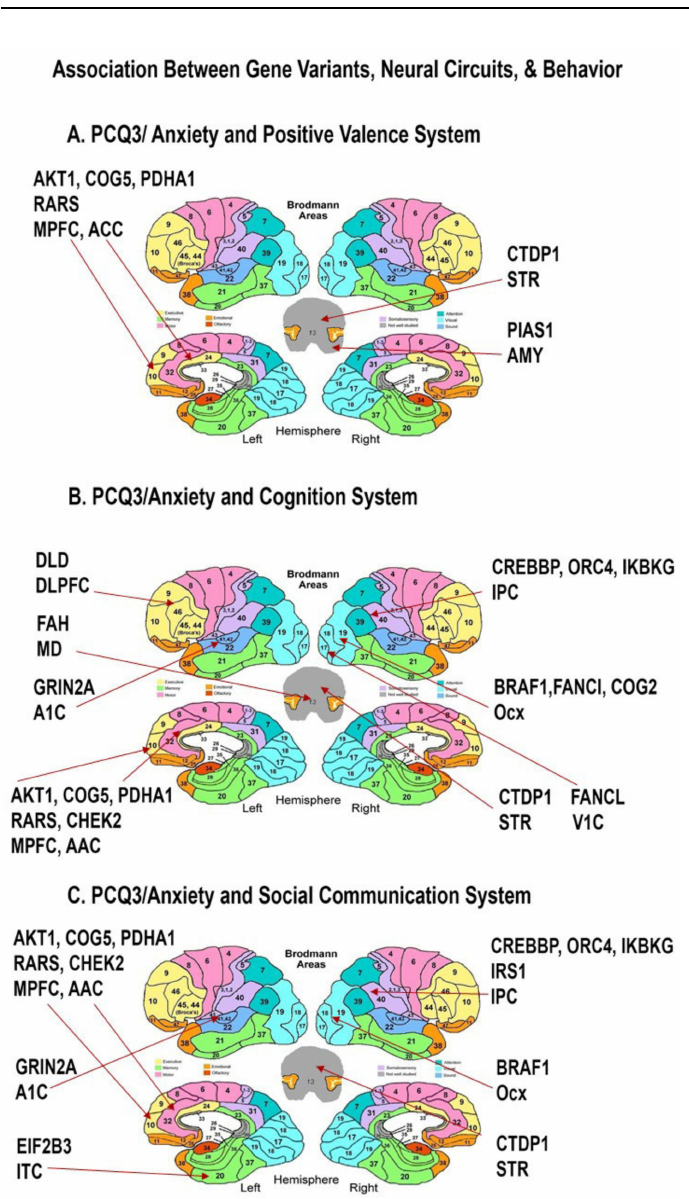
Figure 3. Neural Mapping of the Genes Associated with Parental Questionnaire Anxiety Scores . Map of the peak antenatal expression of genes in RDoC neural-derived circuits (as defined by NIMH) and elevated reported levels of PCQ3 anxiety scores. As expected, significantly associated genes are expressed in the Positive Valence (Reward), Cognition, and Social Communication circuits (Table 2). Furthermore, the expression was restricted to a set of Brodmann areas mediating known ASD rele- vant circuits involving cellular metabolism, neurotrophic, and neuroinflammatory pathways. ACC Anterior Cingulate Cortex, Amy Amygdala, STR striatum, OCx occipital cortex, DLPFC dorsolateral prefrontal cortex, MD mediodorsal nucleus of thalamus, A1C primary auditory cortex, IPC inferior parietal cortex, STR striatum, V1C primary visual cortex (area V1/17), ITC inferolateral temporal cortex (area 20), VLPFC ventrolateral prefrontal